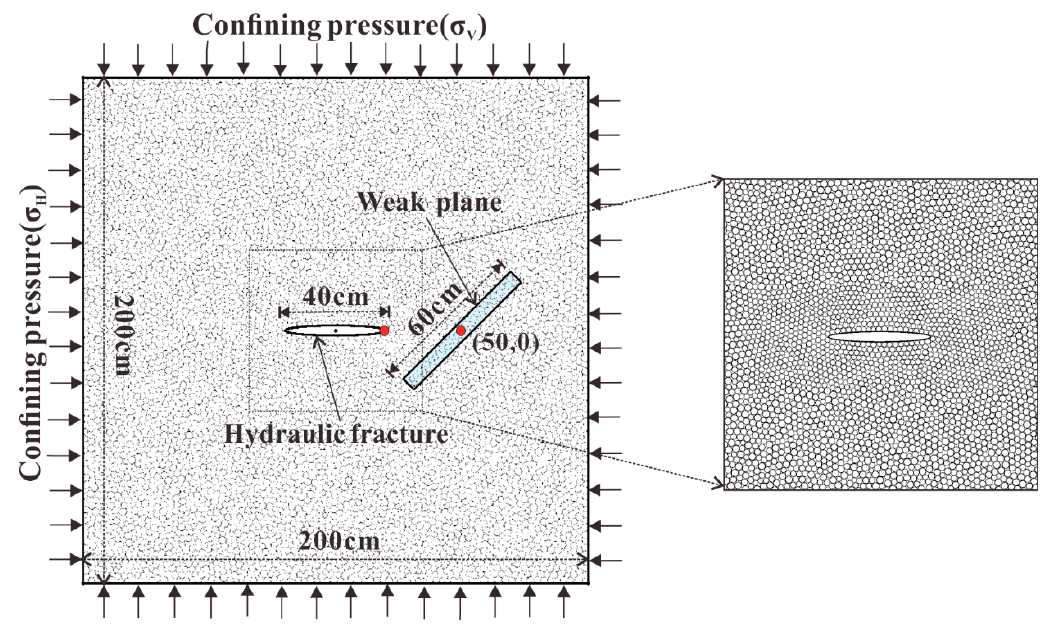
Figure 7. Model of the simulation experiment.